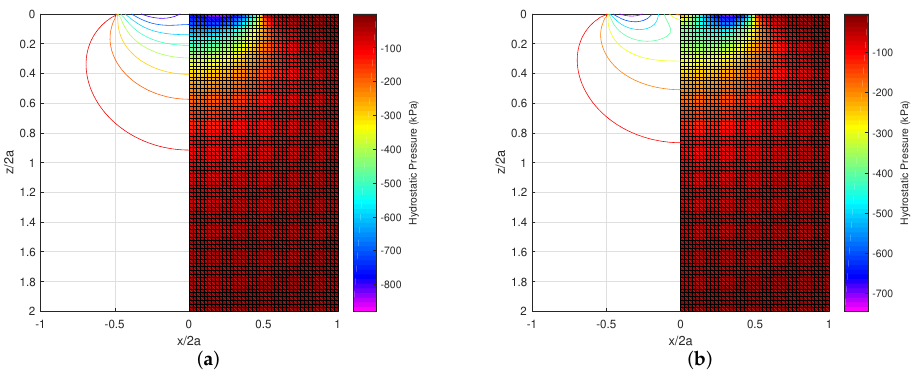
Figure 16. Hydrostatic pressure P in the xz -plane beneath loading cases ( a ) N4-T0 (frictionless) and ( b ) N4-T0.3.